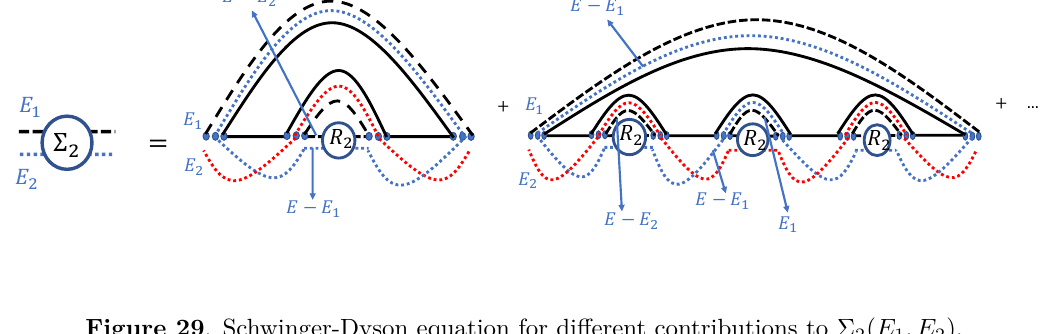
Figure 29 . Schwinger-Dyson equation for different contributions to Σ 2 ( E 1 , E 2 )